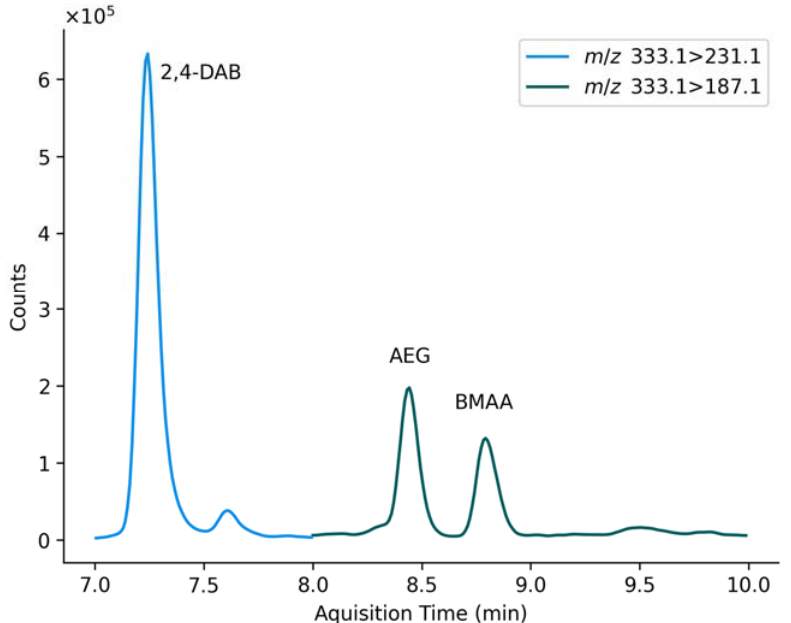
Figure 3. Representative chromatogram of quantitative ion transitions for 2,4-DAB ( m / z 333.1 →